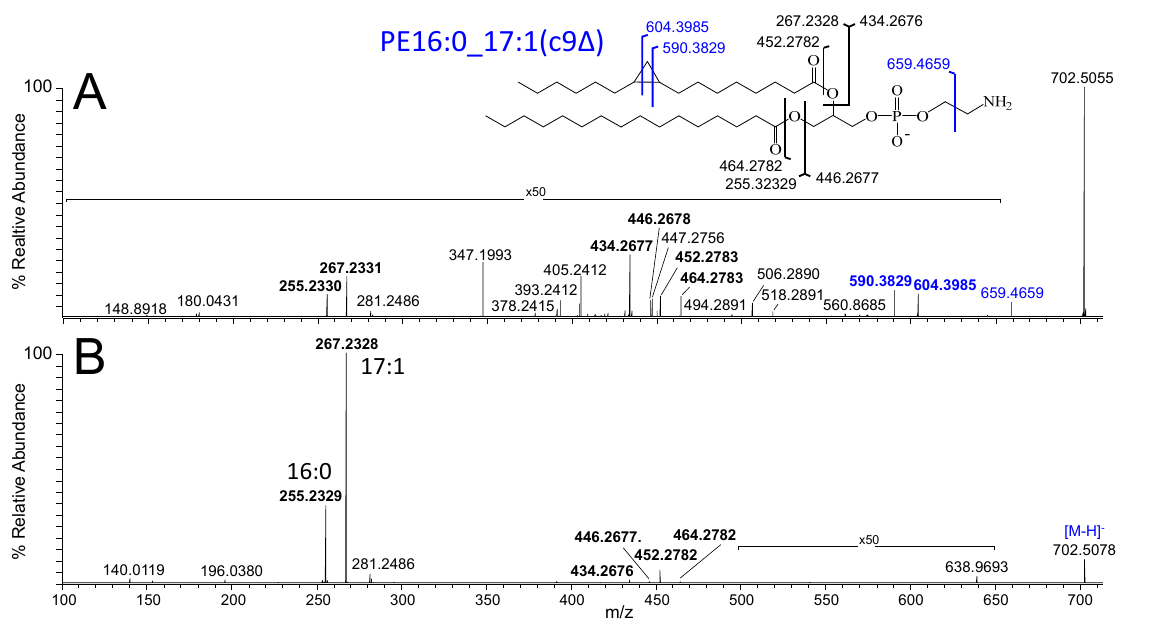
Figure 4. Negative ionisation mode spectra obtained by ( A ) 213 nm UVPD-MS/MS and ( B ) CID- MS/MS for structural characterisation of the [M–H] − precursor ion of E. coli PE(33:1) observed at 733.5045 m/z in Figure 2 as predominantly containing PE16:0_17:1(c9 Δ ) under SGP conditions. The structure shown in the inset indicates the assigned bond cleavage sites for the major product ions. Product ions labelled in blue text are unique to UVPD.